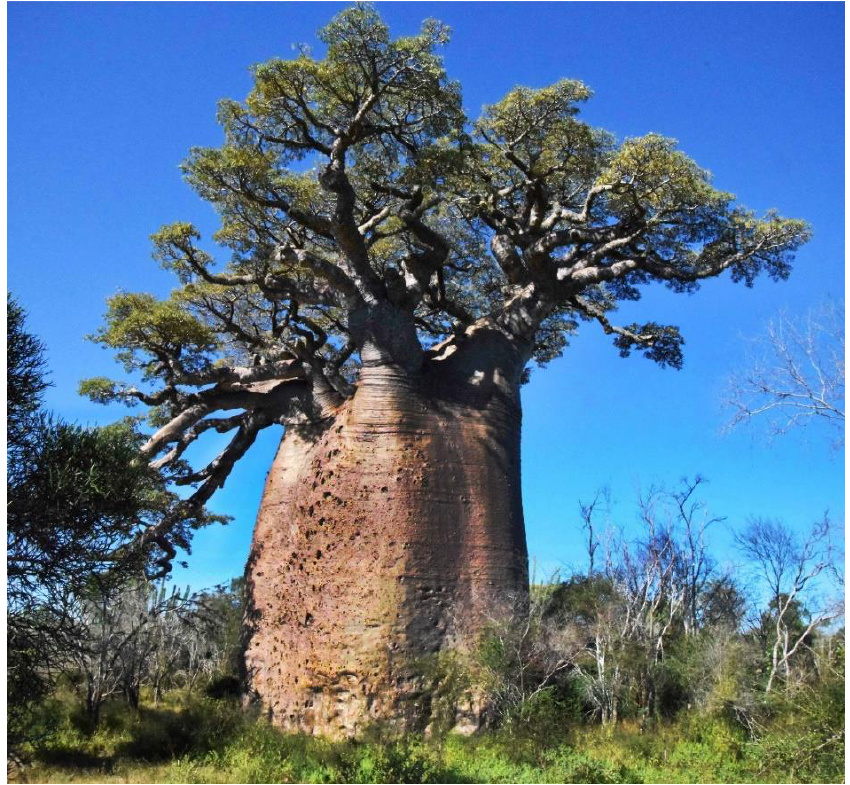
Figure 3. Photo of A 257 from the north, showing its branches pointed upward, while some are directed toward the